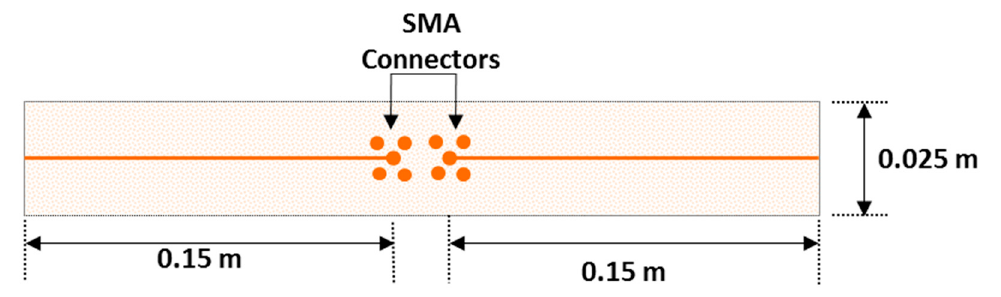
Figure 3. Small dipole antenna with coaxial balun used as electric field probe. The arms are connected through SMA ports to coaxial cables.